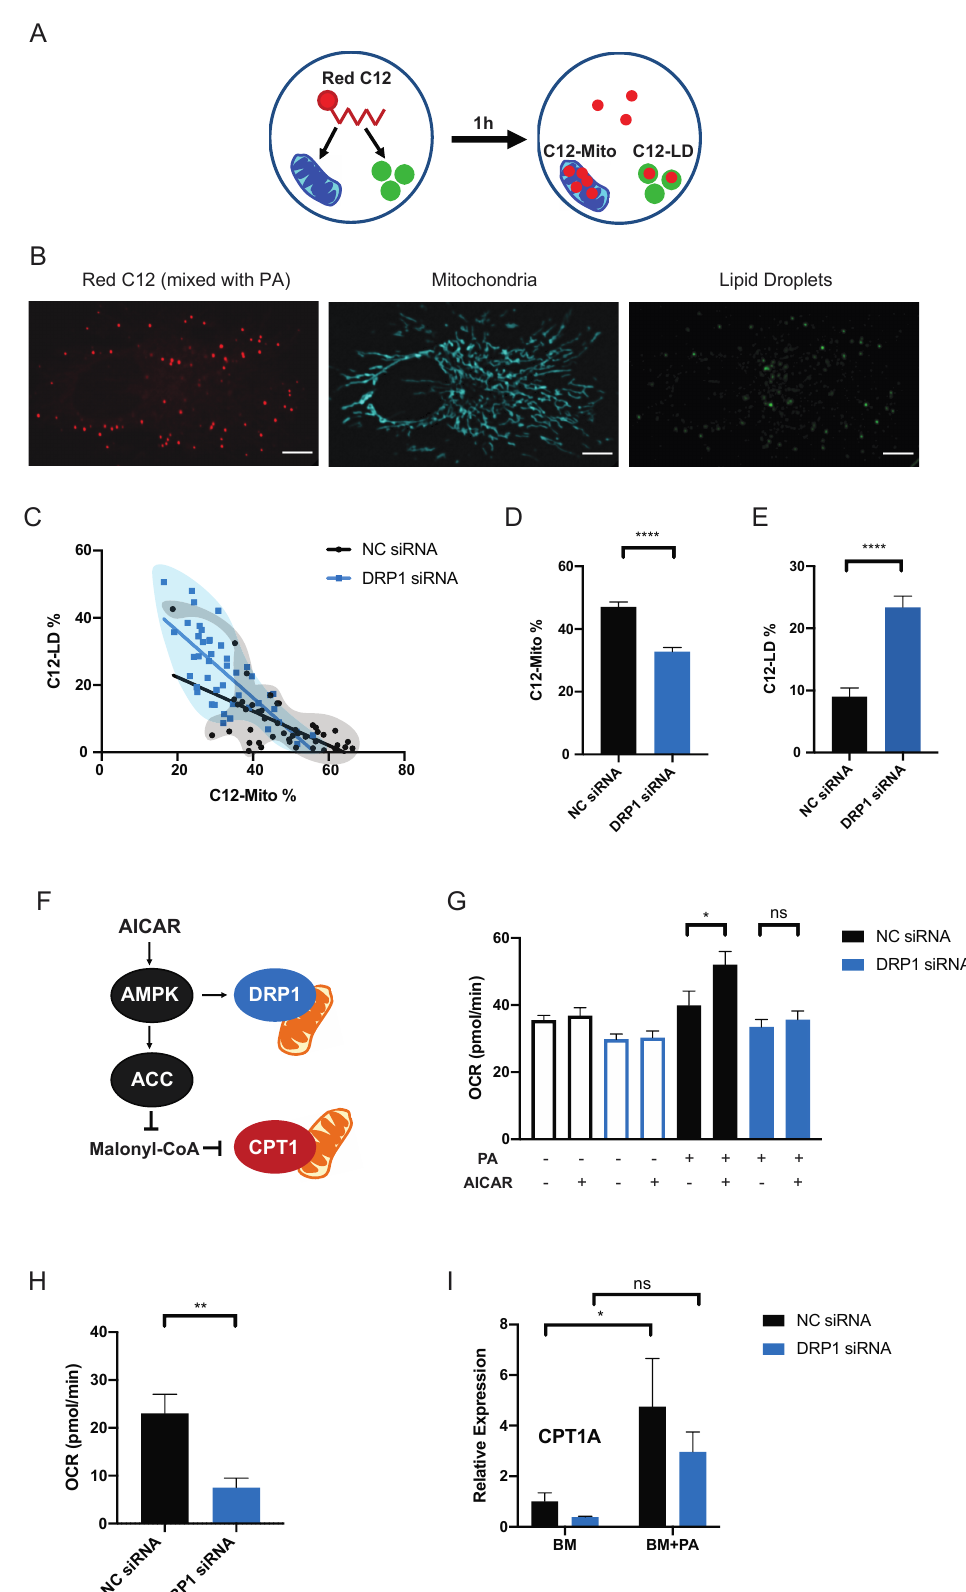
Figure 3. DRP1 directs the distribution of exogenous fatty acid between mitochondria and lipid droplets. ( A ) After 1-h incubation with Red C12, the total Red C12 fluorescence intensity per cell and the C12 fluorescence intensity coming from mitochondrial ROI (C12-Mito) and lipid droplets ROI (C12-LD)